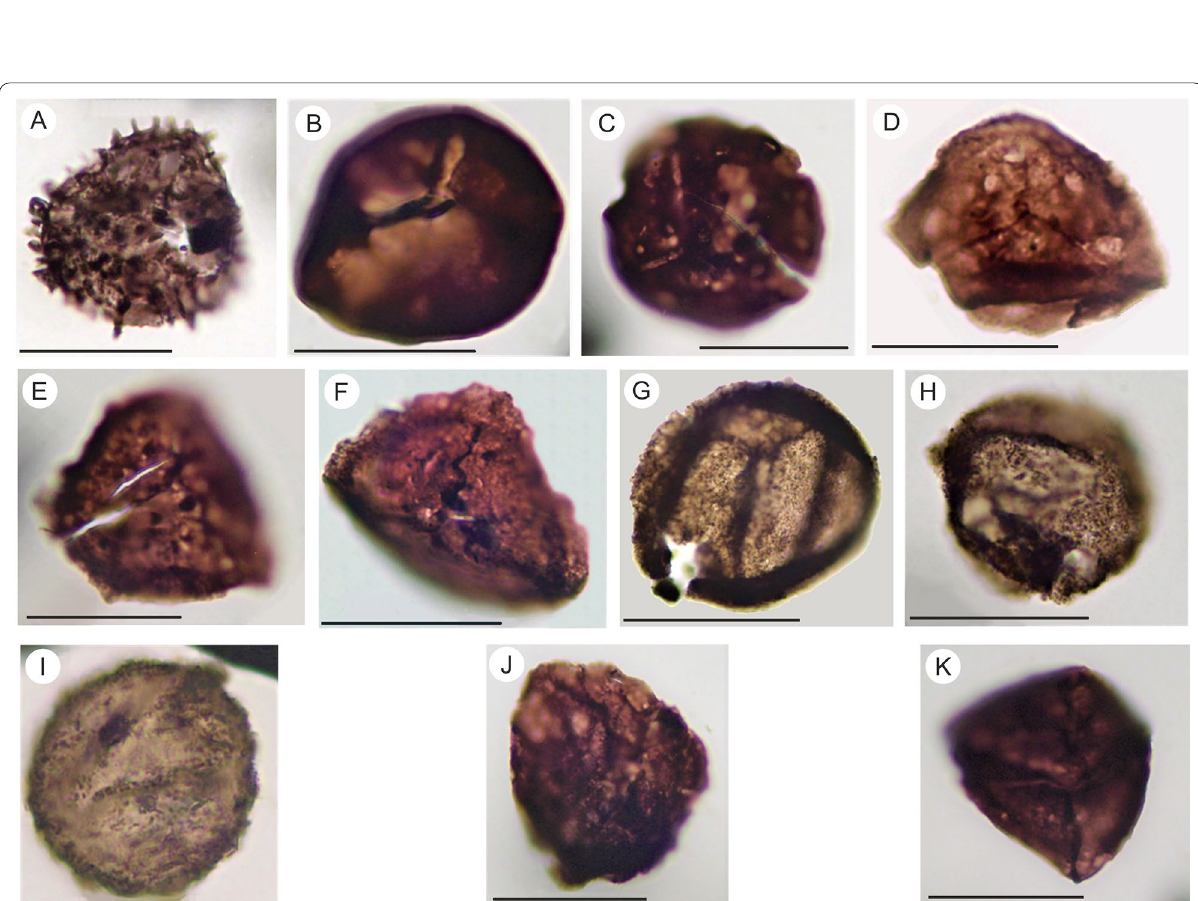
Fig. 5 Lower Carboniferous continental and marine palynomorphs from the Aït Yalla and Tinerhir formations. Scale bar for all: 40 μm. EF: England Finder Coordinates. A Raistrickia cf. radiosa , sample SP6, slide 1, EF C53. B Retusotriletes sp., sample SP7, slide 2, EF N36. C Retusotriletes sp., sample SP8, slide 1, EF R34. D Rotaspora cf. knoxi , sample SP8, slide 1, EF U34/2. E Verrucosisporites sp., sample SP4, slide 3, EF T31/1. F Vallatisporites aff. ciliaris , sample SP8, slide 2, EF R22/2. G Lophosphaeridium spp., sample SP6, slide 1, EF C19/1. H Lophosphaeridium spp., sample SP5, slide 3, EF Y34/1. I Lophosphaeridium spp., sample SP4, slide 2, Y50/1. J Unrecognizable miospore 1, sample SP8, slide 1, EF W44/2. K Unrecognizable miospore 2, sample SP6, slide 2, EF